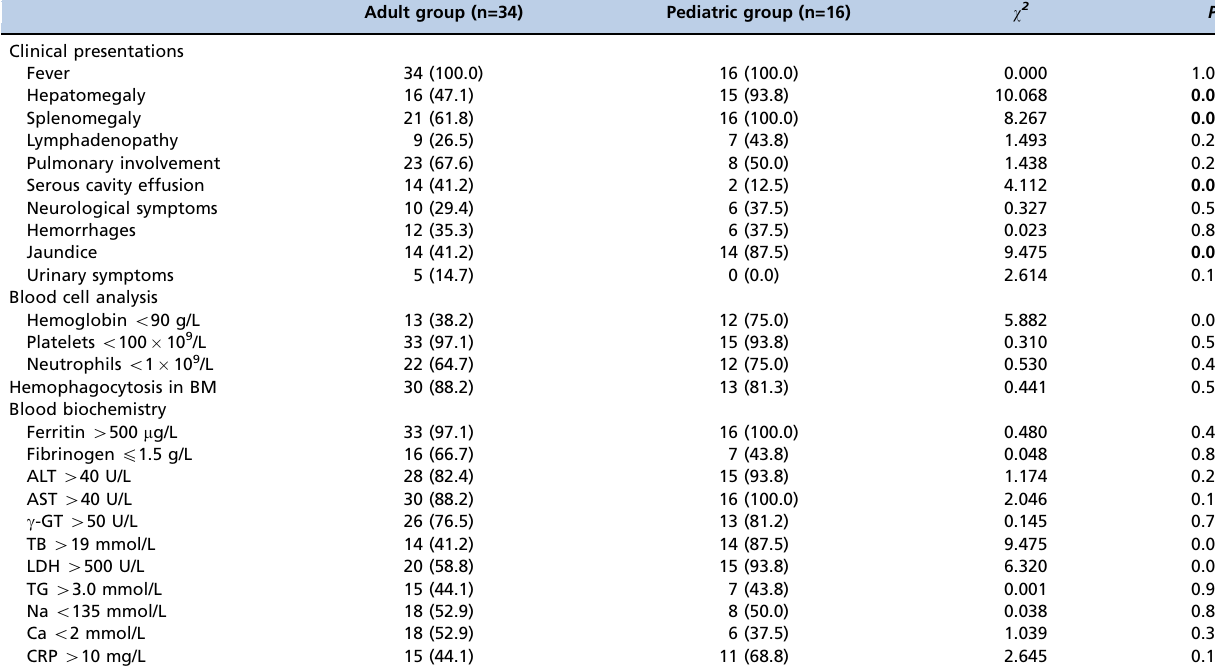
Table 2 - Clinical and laboratory findings in adult and pediatric HLH patients at diagnosis (n, %).